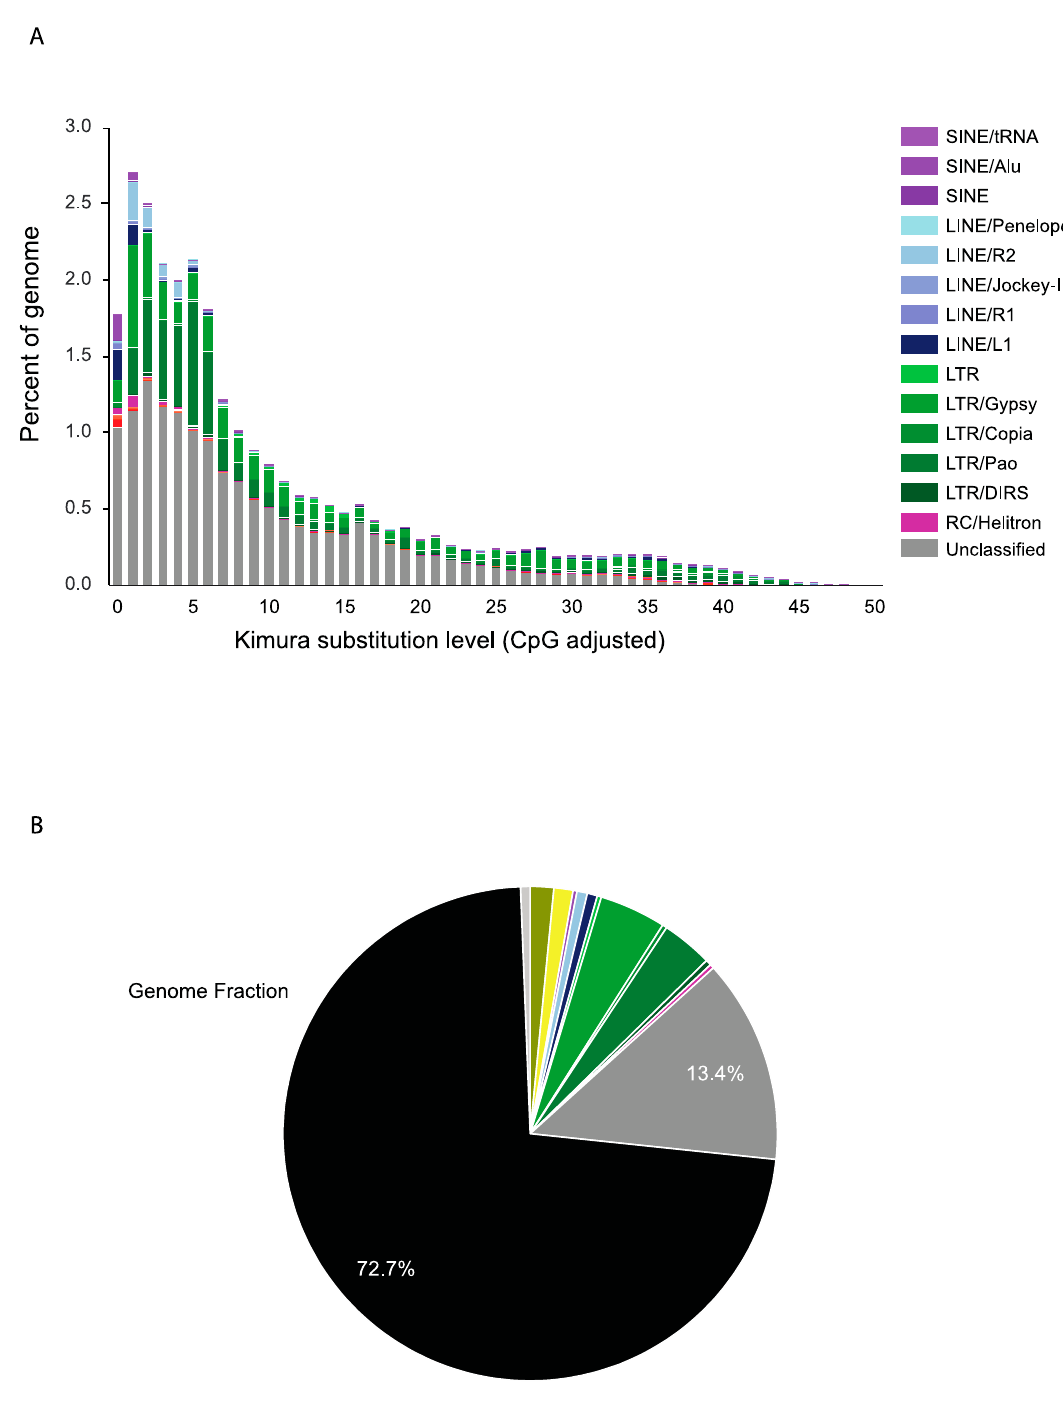
Figure 2. ( A ) Repeat landscape annotation in D. arabica genome. ( B ) D. arabica whole genome characterization with black color of the pie chart reflecting the total genome not occupied with repeats.